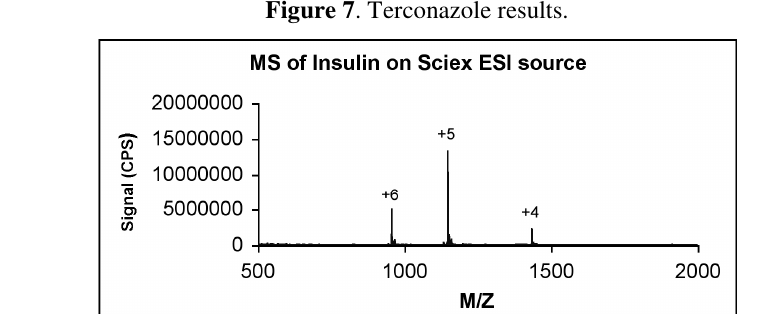
Figure 7 . Terconazole